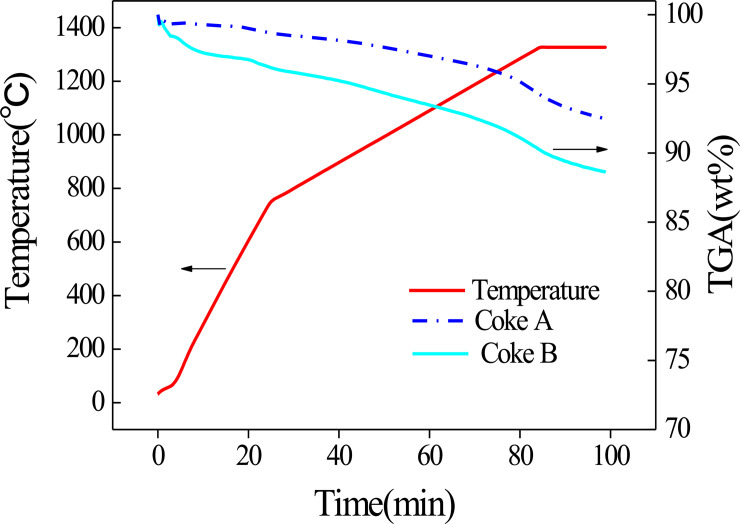
TGA curve of coke.